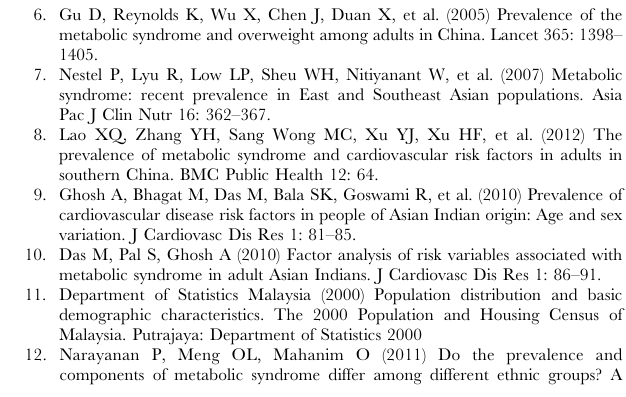
Table S1 Respondent characteristics by ethnicity.